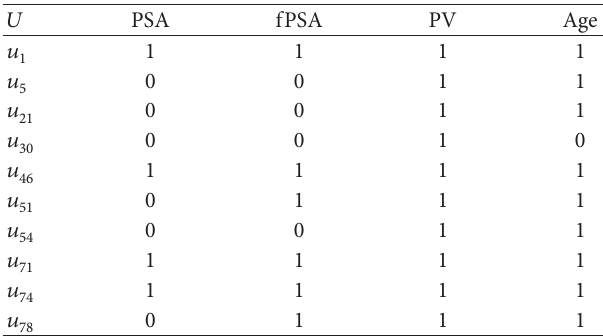
Table 3: Tabular presentation of the soft set 𝐺 = (𝐹,𝐴) .